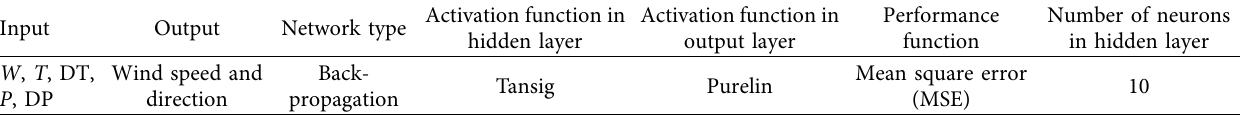
Table 3: Network